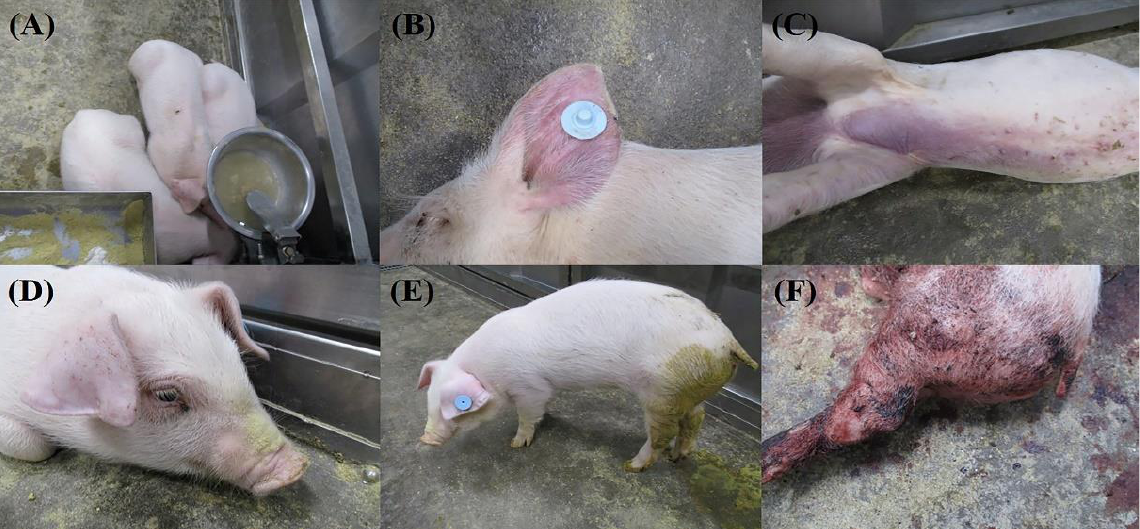
Figure 2. Clinical signs of pigs infected with four ASFV isolates from South Korea from 2019 to 2021. ( A ) Group 1 pigs huddling together at 5 DPI, ( B ) skin hemorrhage on the left ear of pig no. 4 at 5 DPI, ( C ) skin hemorrhage on the trunk of pig no. 7 at 4 DPI, ( D ) ocular discharge in pig no. 4 at 5 DPI, ( E ) diarrhea in pig no. 4 at 4 DPI, ( F ) bloody diarrhea in pig no. 5 at 4 DPI.